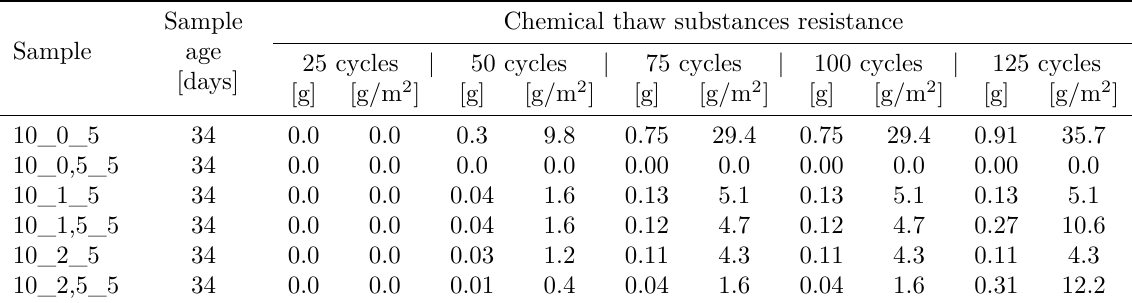
Table 9. Series no. 10 - Results of the resistance to chemical thaw substances